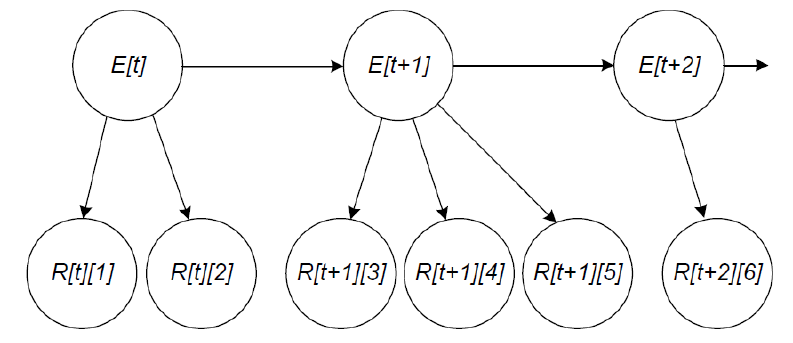
Figure 8. Bayesian network for fake news